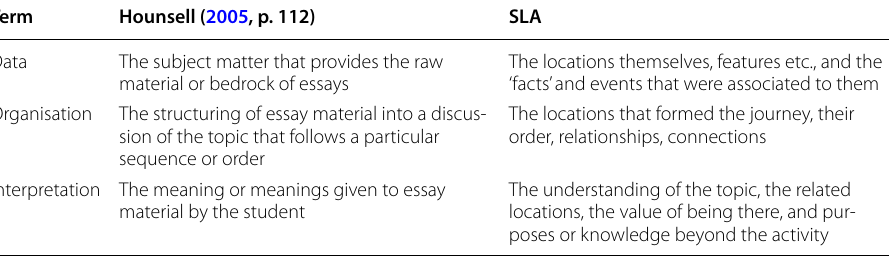
Table 6 Hounsell’s definitions of data, organisation and interpretation sub components, adapted for a SLE Term Hounsell (2005, p. 112) SLA